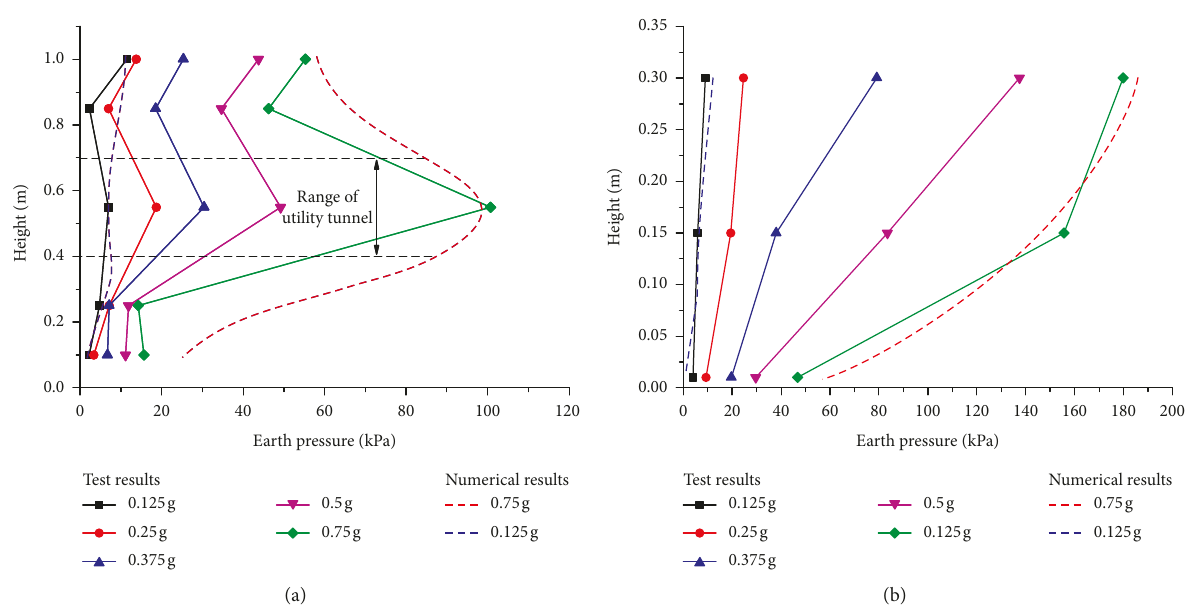
Figure 15: Distribution of maximum soil pressure (a) and the pressure on the soil-structure interface (b).